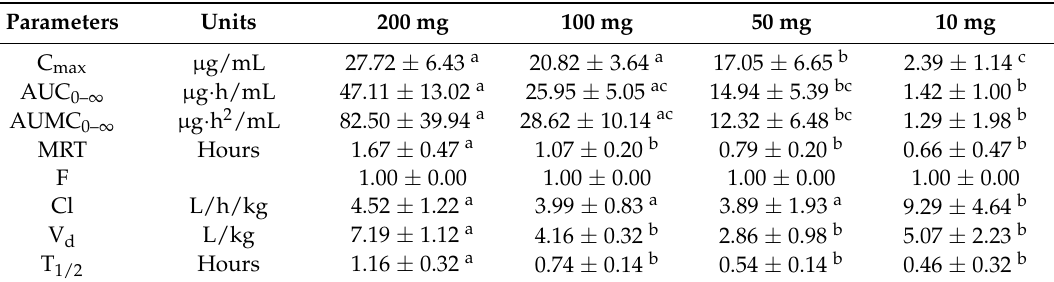
Table 1. Average non-compartment pharmacokinetic parameters of salicylic acid for all dose treatments (single IV SS bolus in sheep) (mean ± SD).